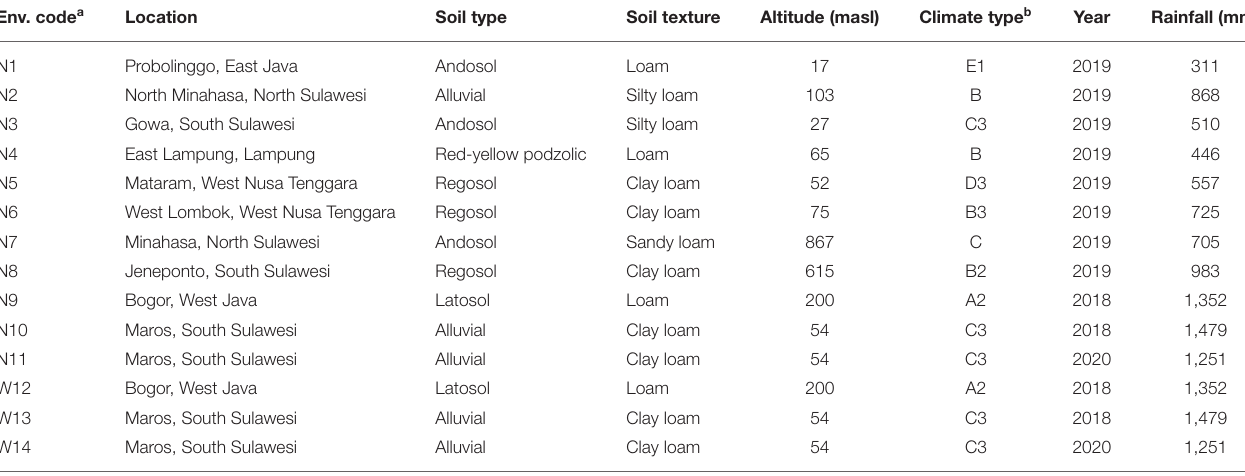
TABLE 1 | Description of 14 environments used for maize hybrids evaluation in Indonesia.